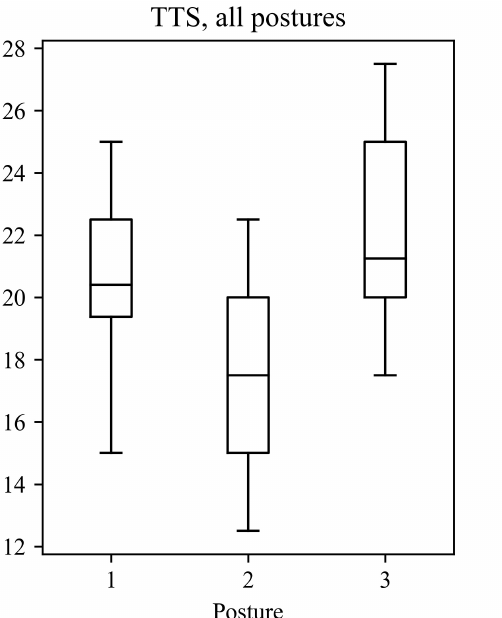
Figure 4. TTS (125 Hz) on the tool handle for all